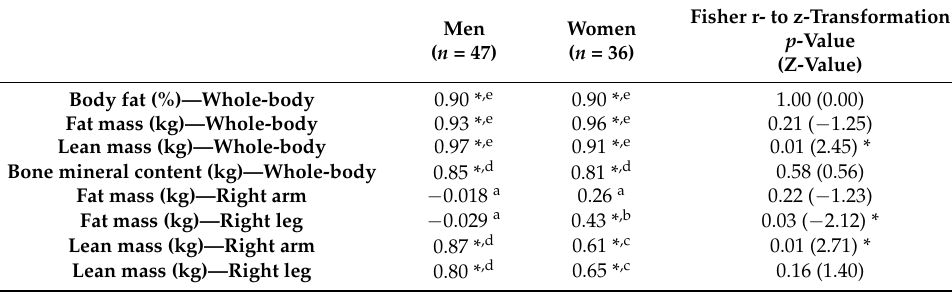
Table 4. Pearson’s r correlation coefficients between BIA and DXA outcome measures for men and women